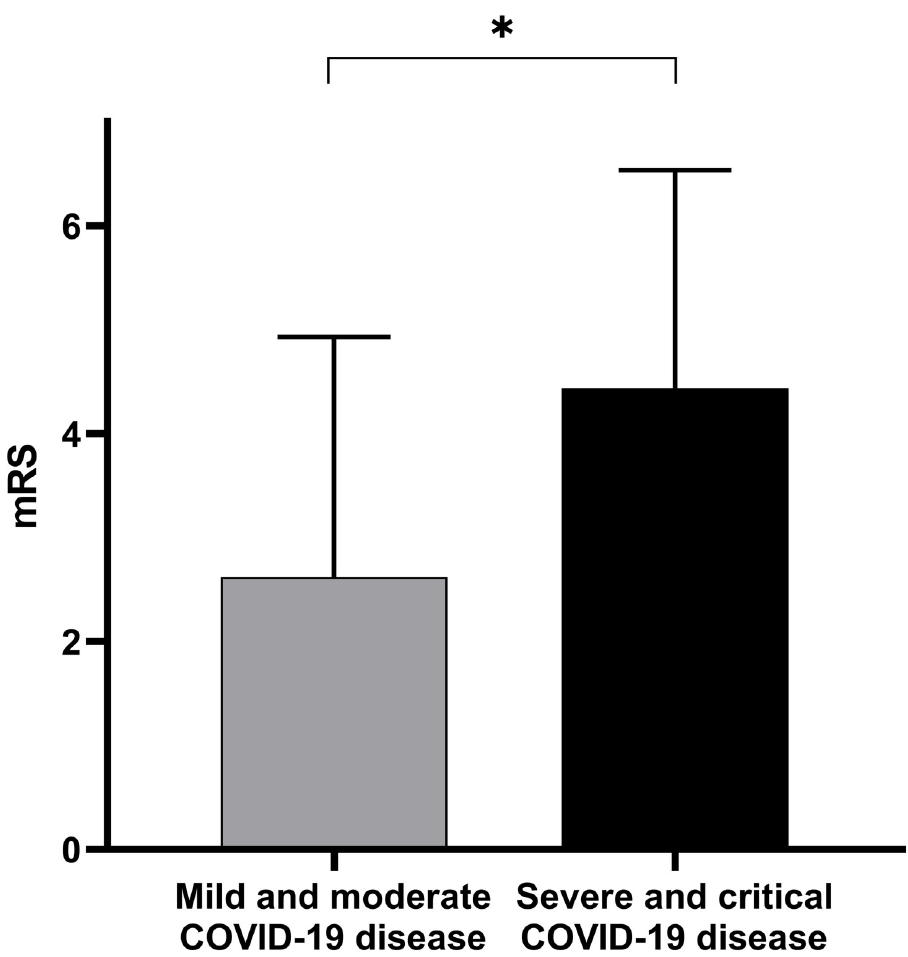
Fig 2. Association between COVID-19 severity and functional outcome. More severe COVID-19 infection resulted in worse functional outcomes (p = 0.01). Data are presented as mean ± SD, � p < 0.05.